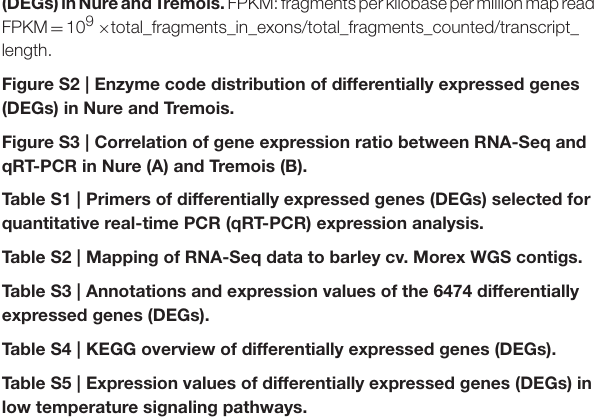
Figure S1 | Genotypedifferenceanalysisofdifferentiallyexpressedgenes (DEGs)inNureandTremois. FPKM:fragmentsperkilobasepermillionmapreads.